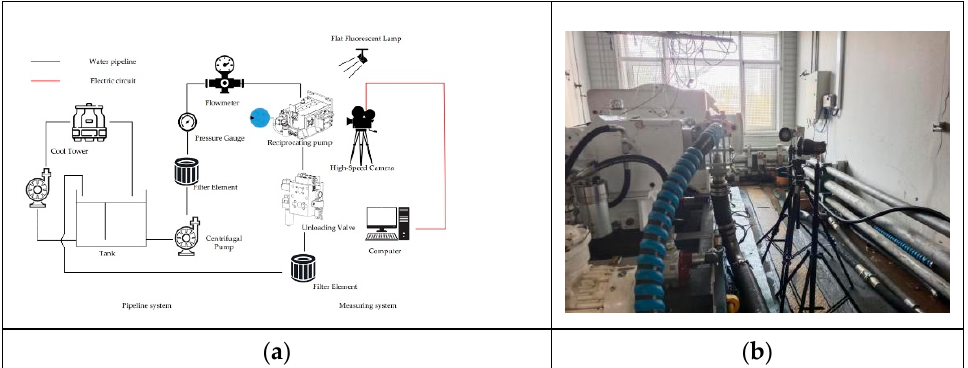
Figure 4. Pump valve visualization test: ( a ) schematic of the experimental setup; ( b ) photograph of the experimental facility.